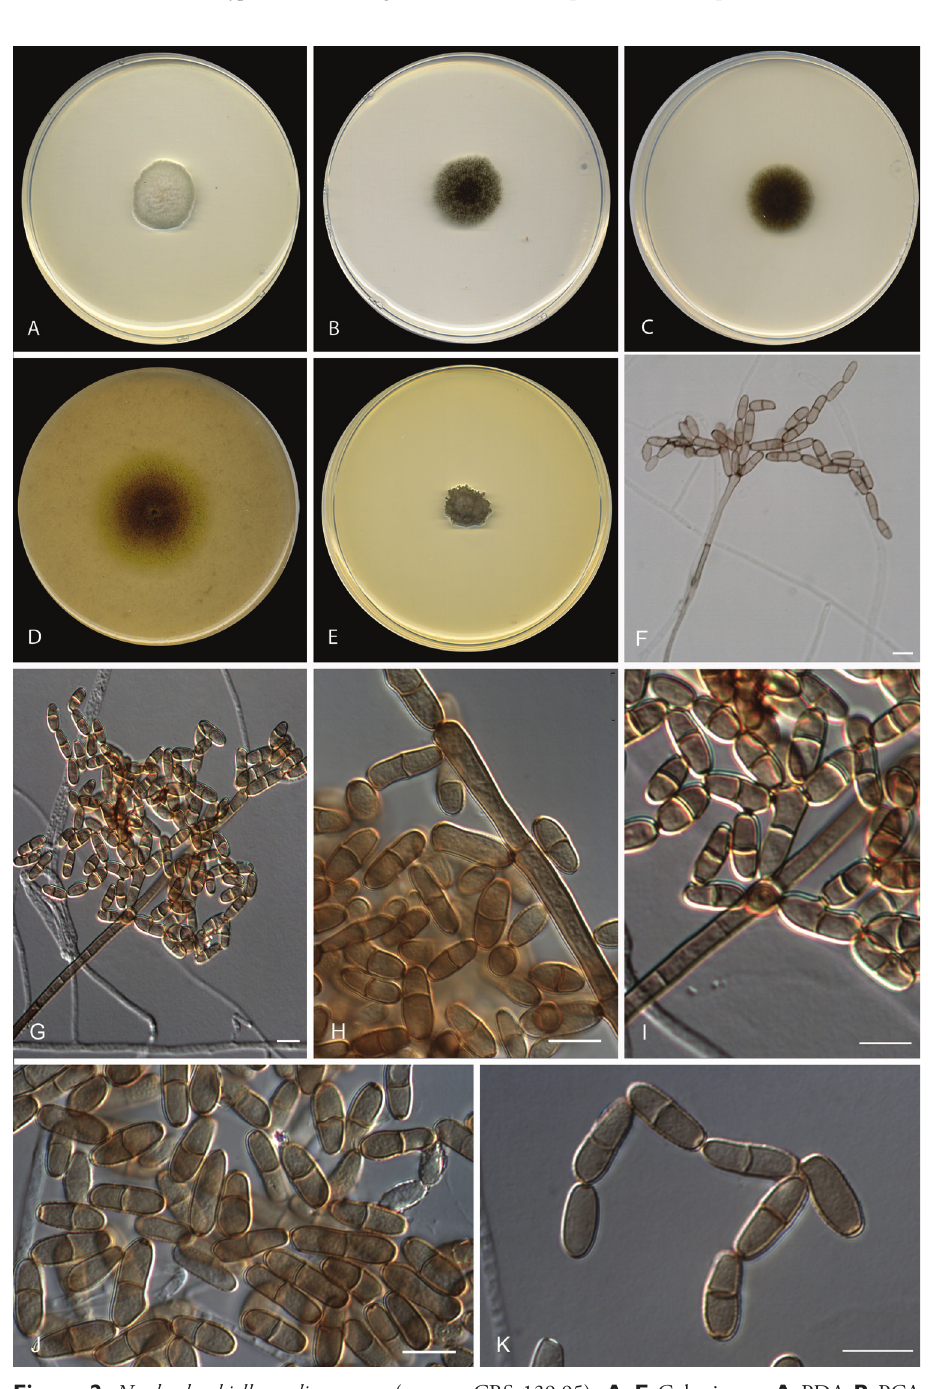
Figure 2. Neodendryphiella mali sp. nov. (ex-type CBS 139.95). A–E Colonies on A PDA B